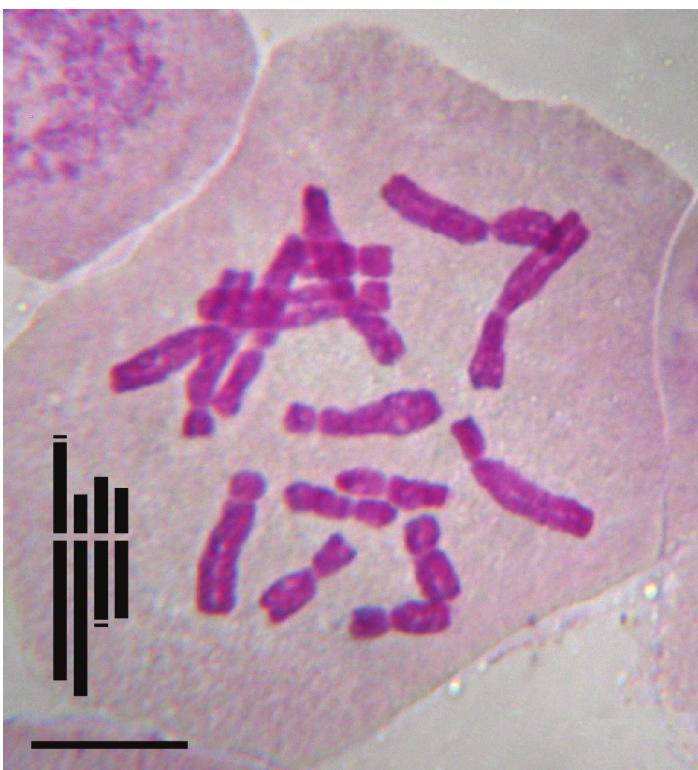
Figure 1. Bellevalia webbiana Parl., 2 n = 16. Metaphasic plate and haploid idiogram. Scale bar: 10 μm.